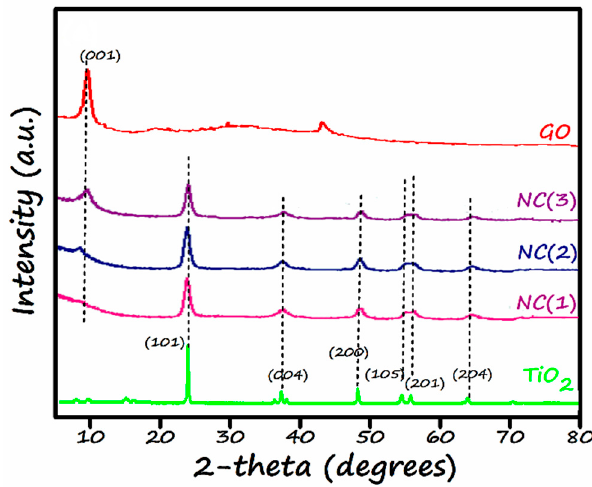
Figure 3. XRD patterns of TiO 2 , GO, NC(1), NC(2) and, NC(3).